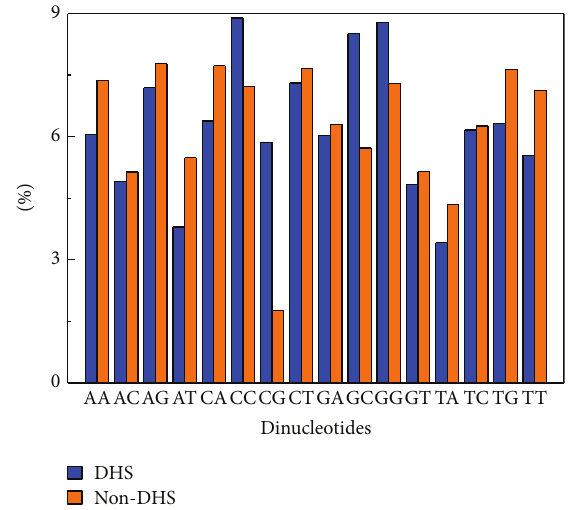
Figure 1: Comparative frequencies of 16 dinucleotides in DHS and non-DHS sequences.